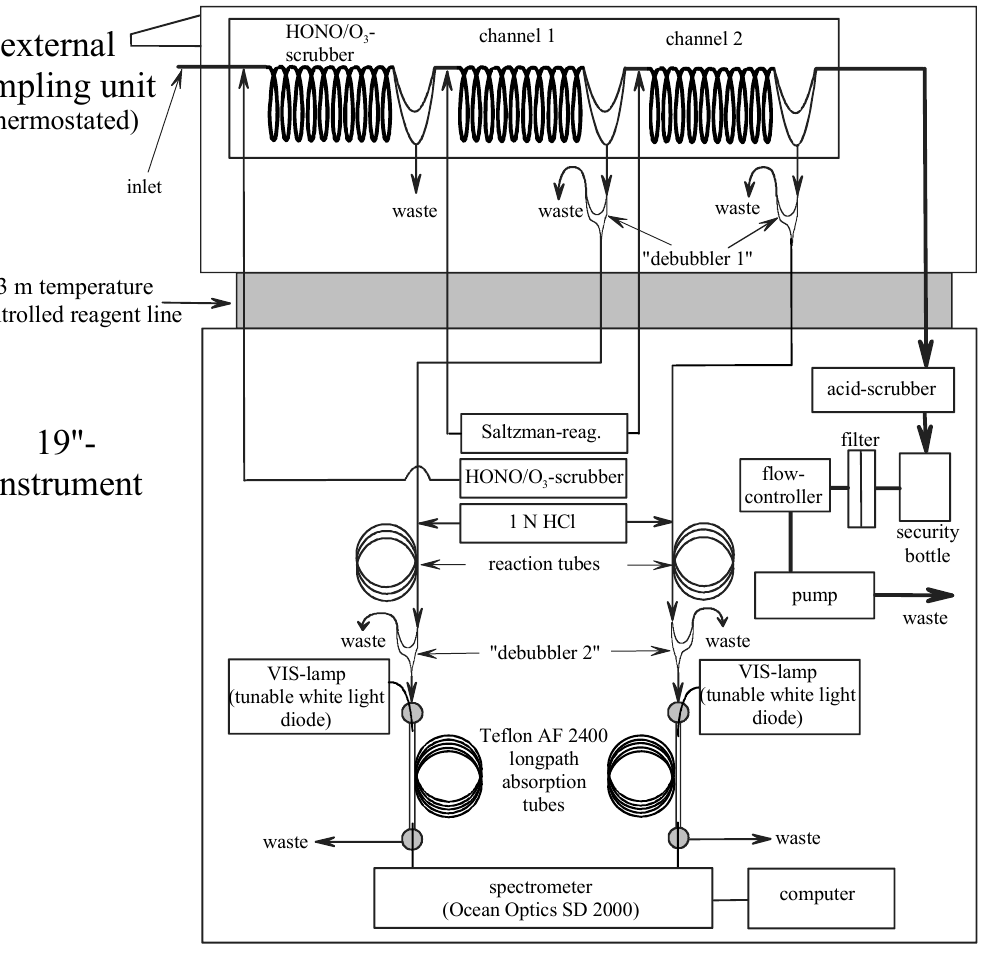
-LOPAP instrument. 2